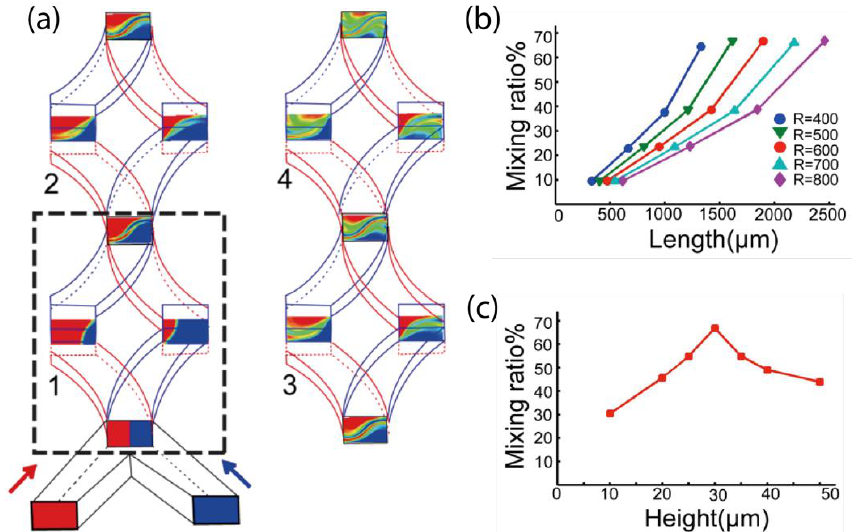
Figure 3. Optimization of mixer structure parameters and mixing ratio. ( a ) Mixing process during the first four cycles of the mixer. ( b ) For each radius R (in µ m), the mixing ratio of the first four cycles is calculated. The length represents the distance from the inlet to the outlet for each of the first four cycles. ( c ) The mixing ratio with different channel height when W = 100 µ m, θ = 45 ◦ , R = 600 µ m, L = 100 μm.